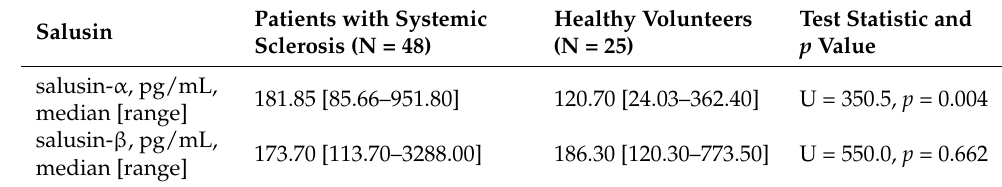
Table 2. Salusin concentrations in the studied groups.